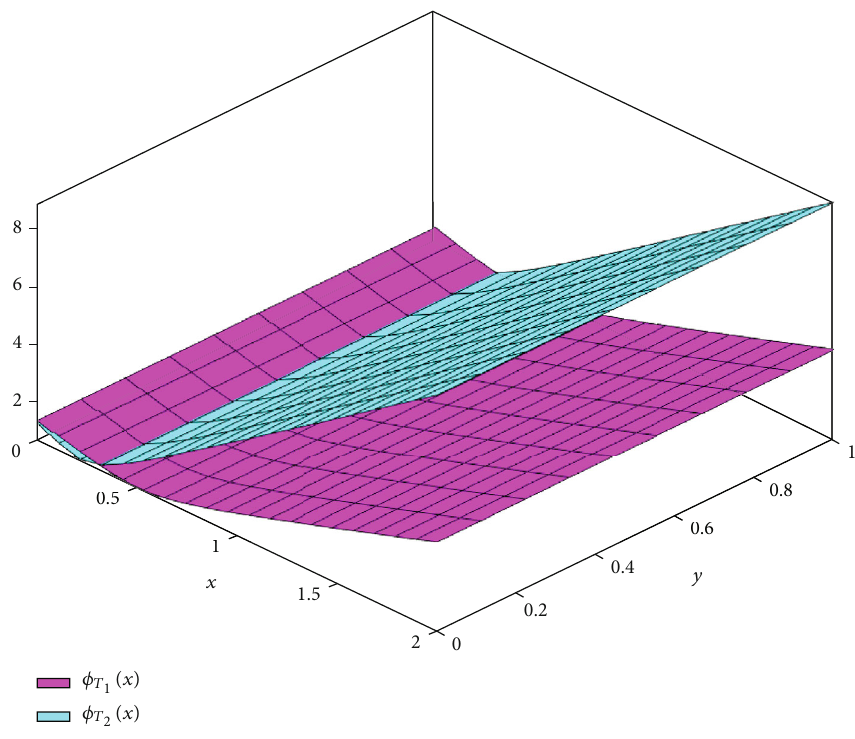
Figure 2: Behaviour of Theorem 8 via a three-dimensional plot satis fi es Example 10.